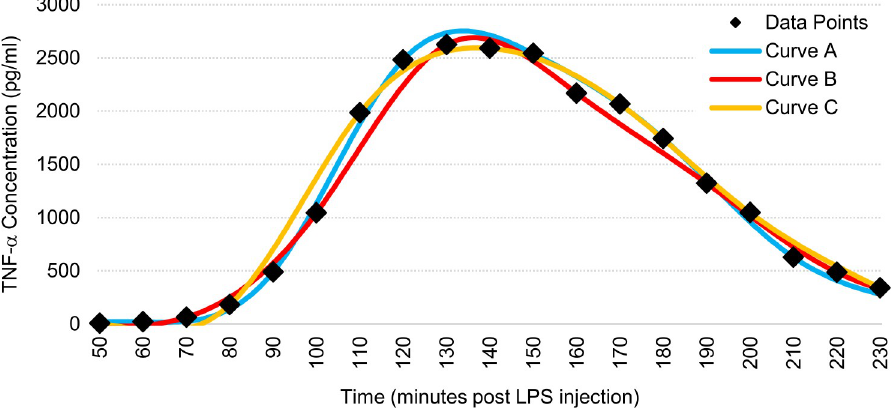
Fig 3. Representative figure demonstrating the effectiveness of our curve-fitting method on a TNF- α cytokine cascade. Data points were taken every 10 minutes. Curve A utilized only points at 60, 90, 120, 150, 180, and 210 minutes. Curve B utilized only points at 70, 100, 130, 160, 190, and 220 minutes. Curve C utilized only points at 50, 80, 110, 140, 170, 200, and 230